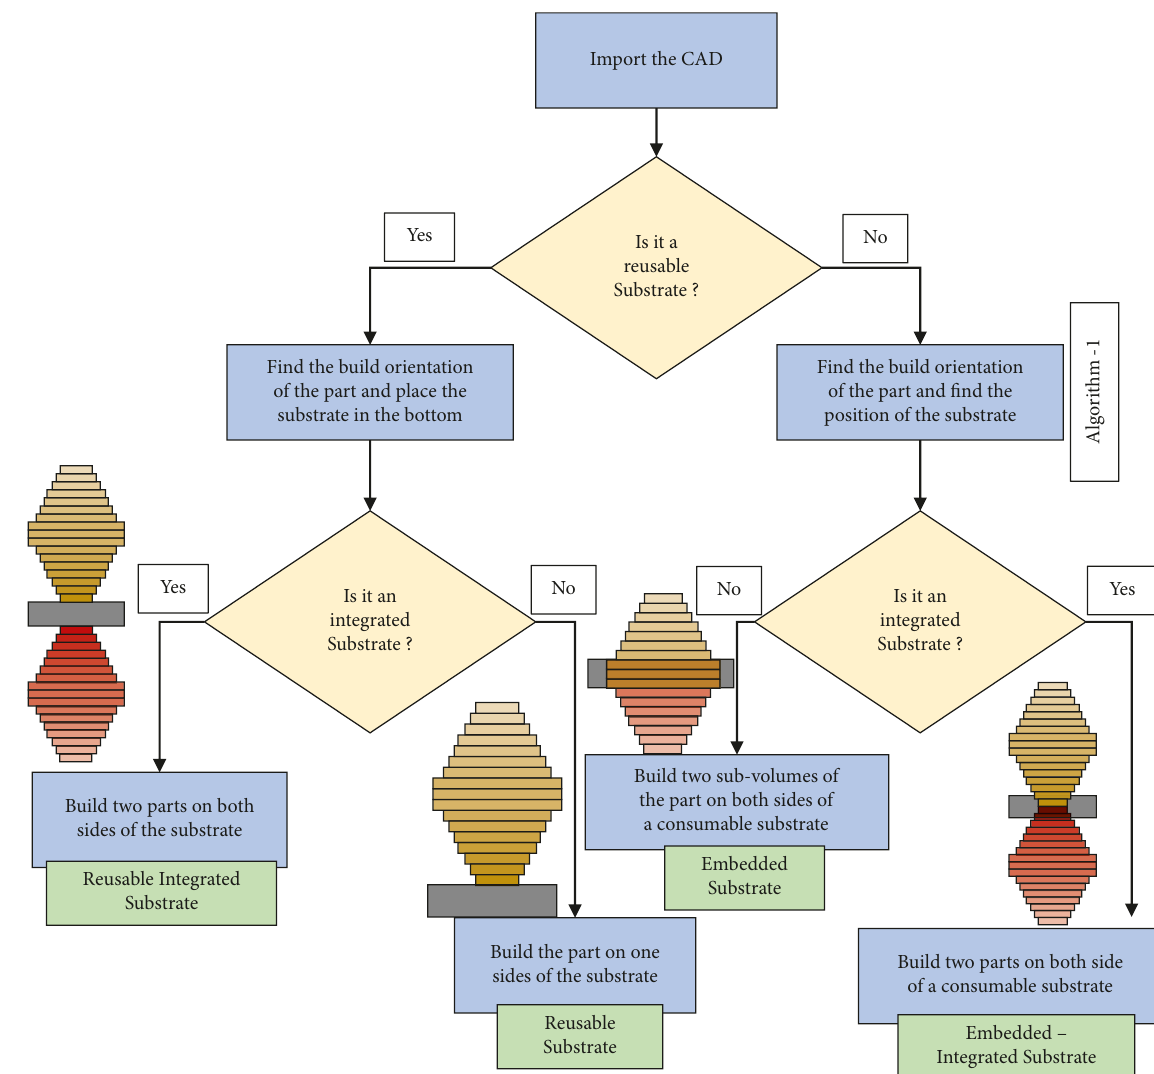
Figure 5: Flow chart for choosing the ideal substrate utilization